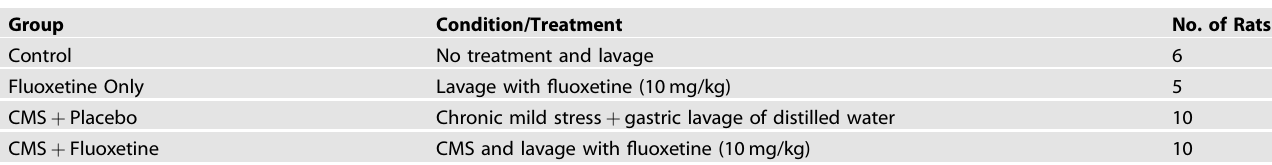
Table 1. The grouping of rats ( n =